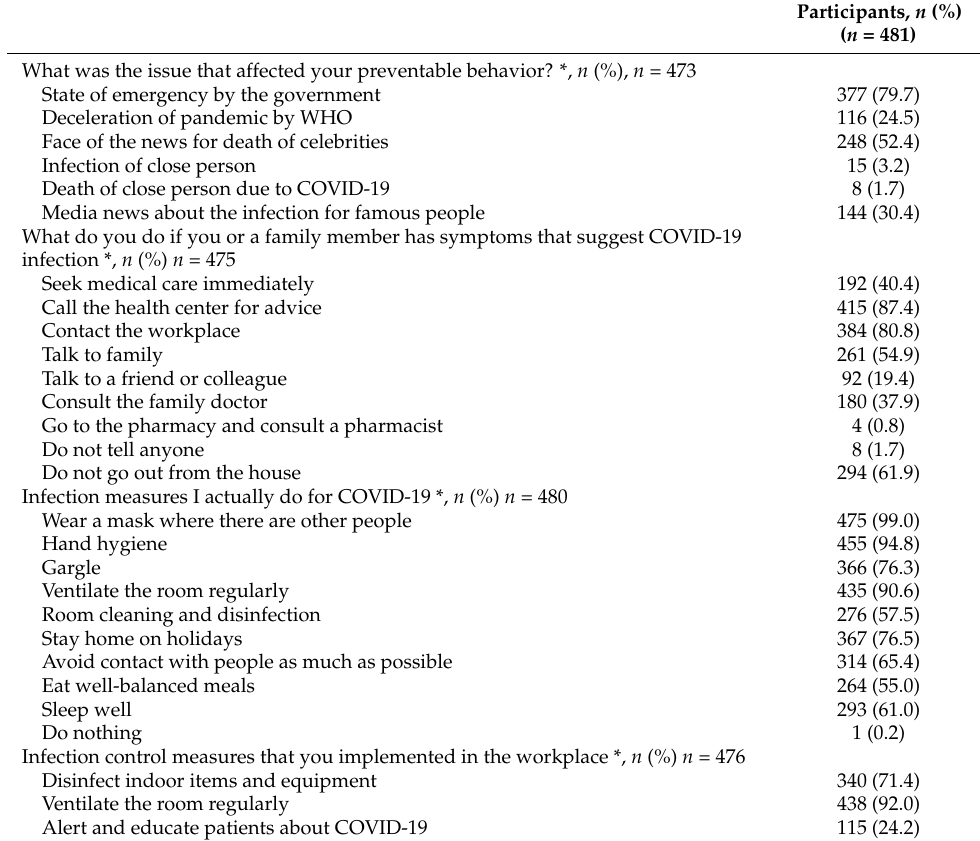
Table 4. Practices relating to COVID-19 among nursing care